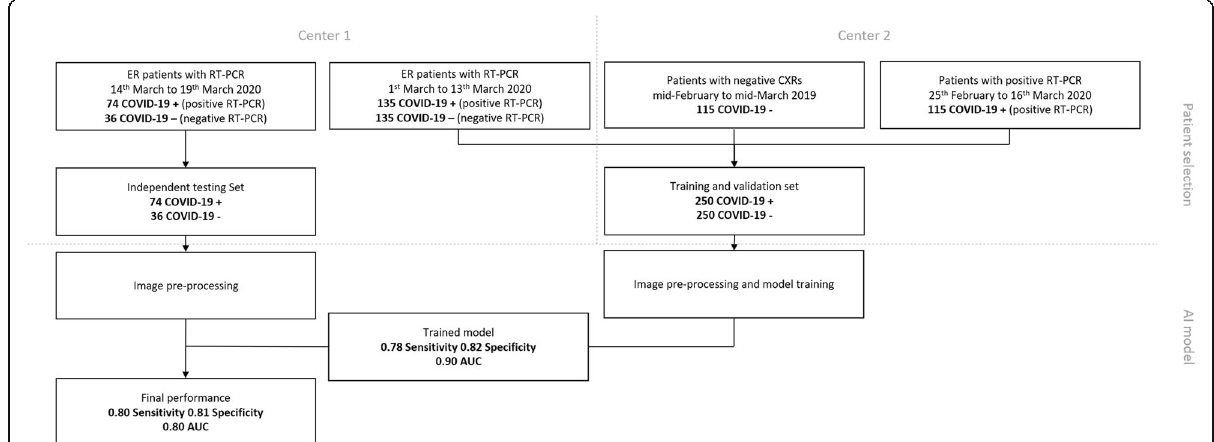
Fig. 1 Flow diagram for patient selection. CXR Chest x-ray, RT-PCR Reverse transcriptase polymerase chain reaction, ER Emergency room, AUC Area under the